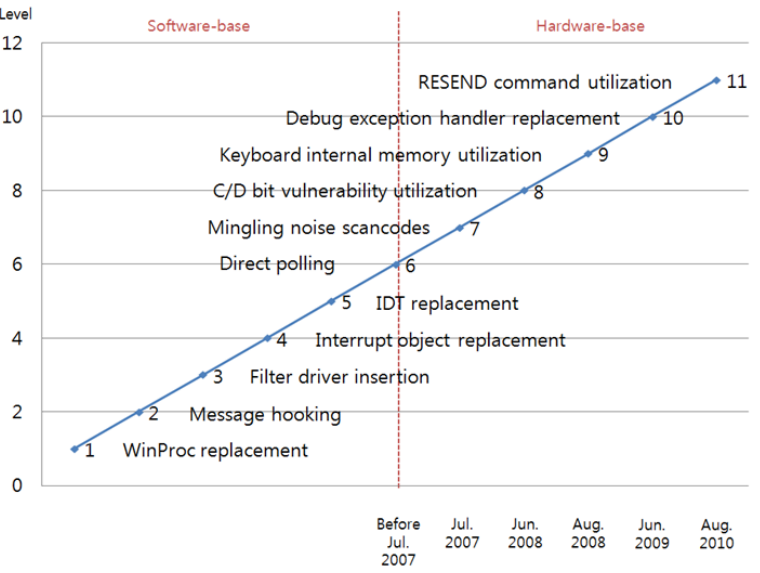
Figure 1. Keyboard attack and protection techniques.